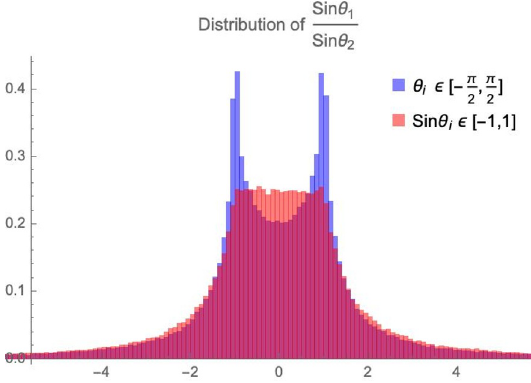
Figure 2 . Probability distribution of the ratio sin θ 1 / sin θ 2 . In blue the θ i angles are taken randomly linearly distributed in the interval [ − π/ 2 , π/ 2] ; in red the sin θ i are taken randomly linearly distributed in the interval [ − 1 , 1]